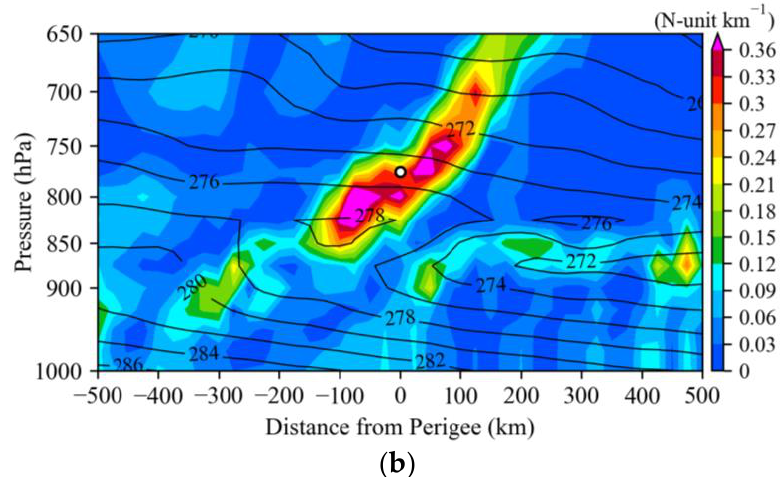
Figure 11. ( a ) Horizontal distribution of the horizontal gradient of refractivity (shaded) and geopo- tential height (contour, unit: gpm) at 775 hPa, and ( b ) vertical cross-section of the horizonal gradient of wet refractivity (shaded) and temperature (contour, unit: K). The perigee point of RO3 is indicated by a black open circle and the ray tangent direction is shown by a black arrow in ( a ). The refractivity gradient is calculated from ERA5 reanalysis at 1500 UTC, 30 August 2020.